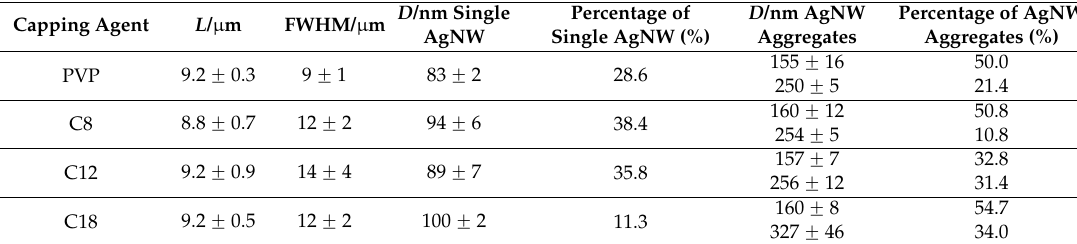
Table 1. Length and diameter values of nanowires with different capping agents. Nanowire Length (L); Full Width at Half Maximum